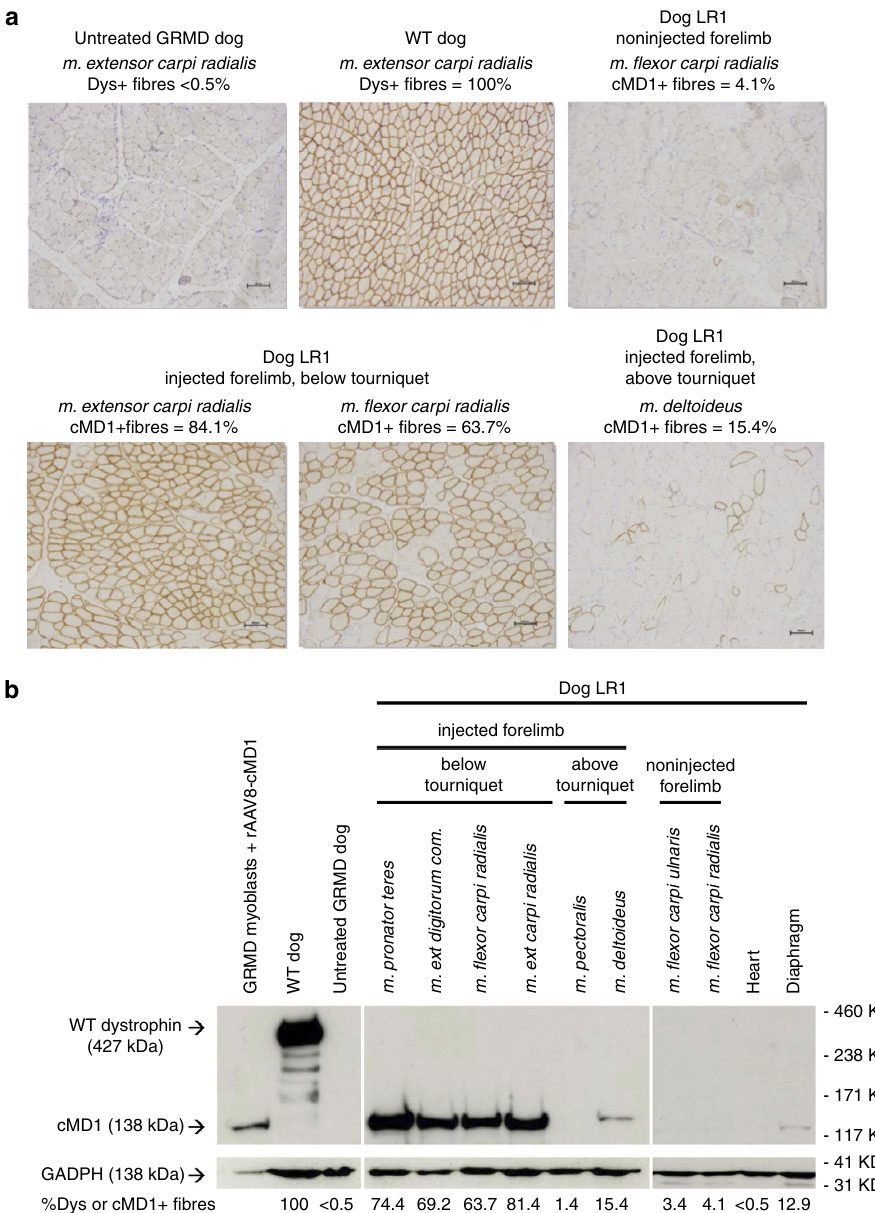
Figure 1 | Analysis of cMD1 expression by immunostaining and western-blot in muscles of GRMD dogs injected with rAAV2/8-Spc512-cMD1 by the LR route. ( a ) Dystrophin immunostaining (NCL-DYSB) on transverse sections of muscle samples. Representative results are presented for healthy (WT) and untreated GRMD dogs and for four different muscles of dog LR1 sampled at the time of killing (non injected and injected forelimb, below and above the tourniquet). Scale bar, 100 m m. ( b ) Western-blot analysis of total proteins (50 m g) extracted from muscles samples. Representative results for the same muscles as in a are shown. GRMD myoblasts transduced with the rAAV2/8-Spc5.12-cMD1 vector were used as positive control. The blot was stained with MANEX-1011C to reveal the presence of the 427kDa dystrophin protein (WT dog) and the 138kDa cMD1 protein, with an anti-GAPDH antibody as a loading control. The level of cMD1-positive fibres detected by immunostaining from the same muscle samples are indicated under each 31 P spectroscopy, signals were measured from the two extensor sarcolemmal membrane stability and muscle tissue metabolism 39 (Fig. 3b). Finally, most imaging indices showed carpi radialis muscles. Visual assessment of 1 H-NMR images in the muscles of the two analysed dogs showed altered magnetic an improvement in the injected compared with the noninjected resonance properties indicating a reduction of edema, forelimbs, with a decrease of the fat-saturated T2w/T1w 1 H-NMR imaging index, and the 31 P-NMR spectroscopic Pi/ g ATP index to inflammation, necrosis and cell damage. Indeed, muscle signals levels close to or within normal ranges of healthy dogs (Fig. 3c,d). were less hyperintense on T2-weighted images and more Taken together, histology, NMR imaging and spectroscopy homogeneous within and between muscles (Fig. 3a). We also analysis confirmed a significant reduction of the dystrophic observed a reversion in abnormal levels of phosphocreatine, pathology in muscles of forelimbs injected with the rAAV2/8- inorganic phosphate and phosphodiesters in 31 P-NMR spectra in Spc5.12-cMD1 vector. the injected forelimbs of treated dogs, reflecting improved